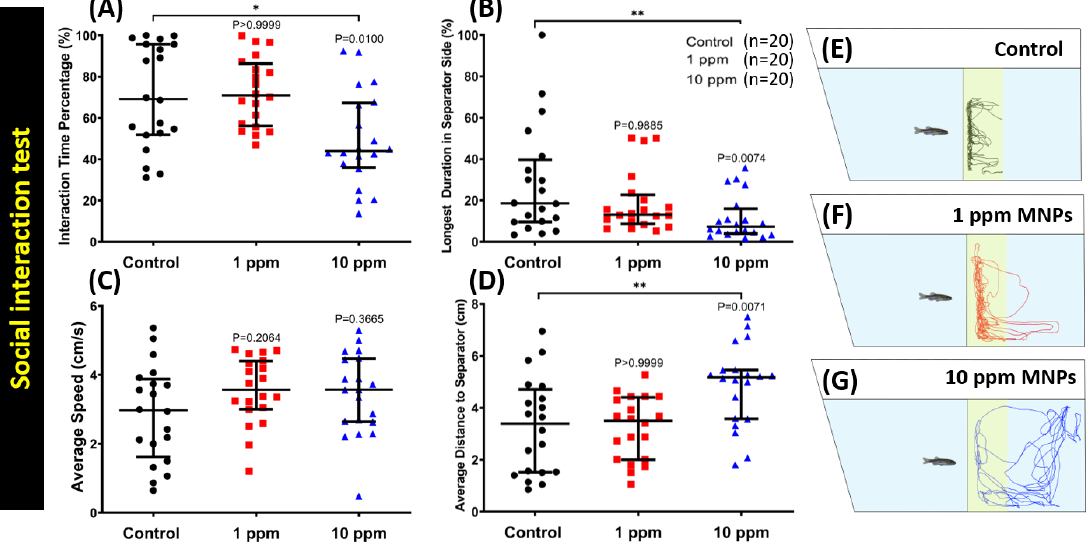
Figure 6. Behavior endpoint comparisons between the control group, 1 ppm, and 10 ppm Fe 3 O 4 MNPs-exposed zebrafish groups after two weeks of exposure. ( A ) Interaction time percentage, ( B ) longest duration in the separator side, ( C ) average speed, and ( D ) average distance to the separator were analyzed. ( E–G ) The locomotion trajectories for the control, 1, and 10 ppm MNPs-exposed fish in the conspecific social interaction test. The data are expressed as the median with an interquartile range and were analyzed by the Kruskal-Wallis test, which continued with Dunn’s multiple comparisons test as a follow-up test ( n = 20, * p < 0.05, ** p < 0.01).